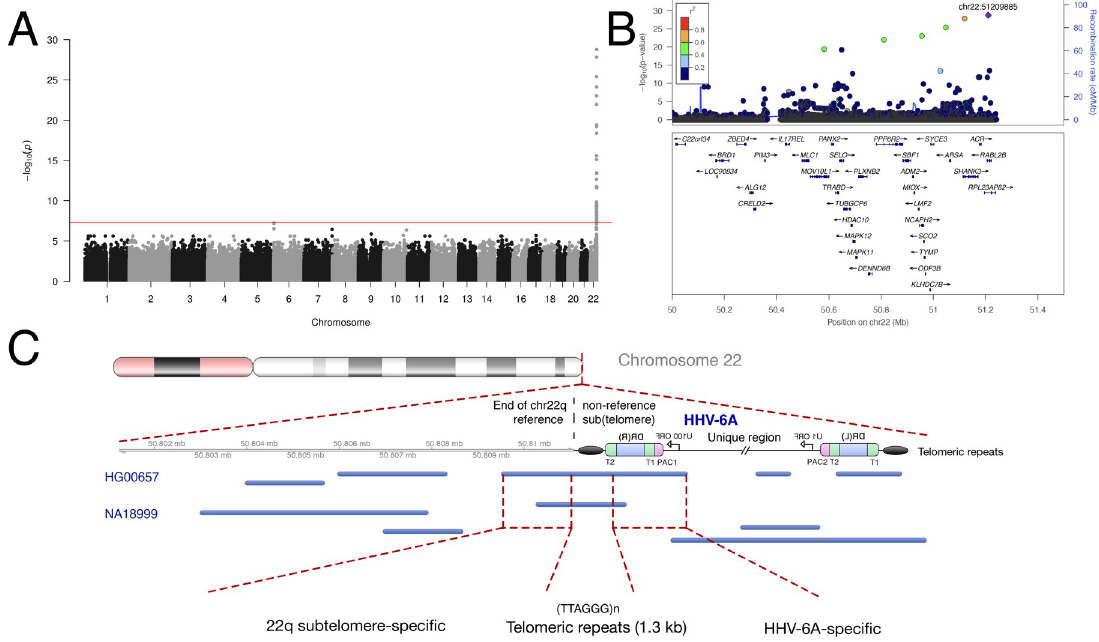
Fig 4. An endogenous HHV-6A variant in East Asians integrated into chr22q. A) Manhattan plot presenting the P values for association between variant and integrated HHV-6A (N = 12). The − log10 P value (Fisher’s exact test) given for each variant is plotted according to the variant’s physical position on the chromosome. B) Regional association plot of the chr22q region. The − log10 P value (Fisher’s exact test) for association in the GWAS of integrated HHV-6A are shown. The purple diamond symbol represents the lead variant in the region of the association. Proxies are indicated with colors determined from their pairwise r 2 from the high-depth BBJ WGS data (red, r 2 > 0.8; orange, r 2 = 0.6 − 0.8; green, r 2 = 0.4 − 0.6; blue, r 2 = 0.2 − 0.4; dark blue, r 2 < 0.2 or no information available). C) Long- read sequencing identifies endogenous HHV-6A integration site. Mapping of individual long sequencing reads (blue lines) to the chr22q reference sequence and to HHV-6A is depicted. Reads were obtained from lymphoblastoid cell lines derived from two subjects with integrated HHV-6A (HG00657 and NA18999) who bear the rare variant rs566665421. The reads that span the integration site are highlighted, demonstrating the integration site of HHV-6A in both subjects is the non-reference terminal heterochromatin of the q arm of